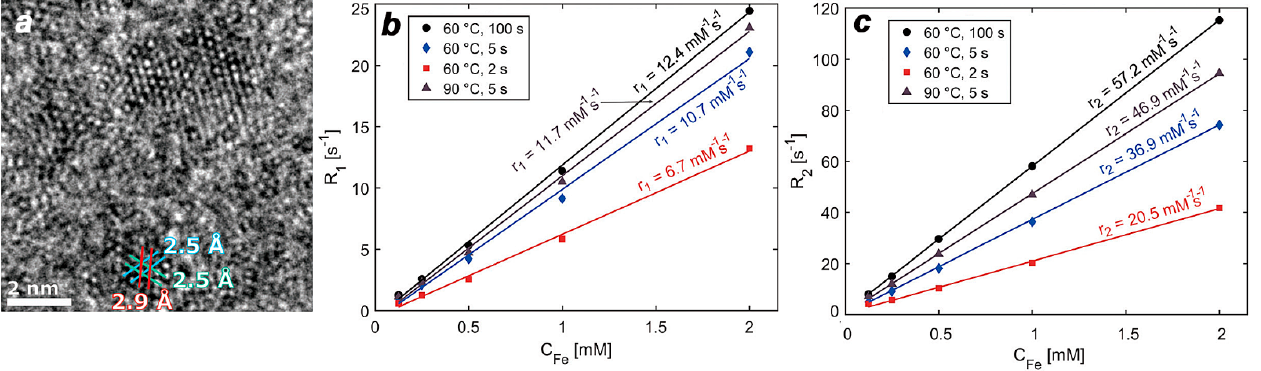
Figure 2. ( a ) HRTEM magnification image of ultra-small IONPs matching the [111] zone axes of magnetite with the two 2.5 Å (113) planes and one 2.9 Å (220) plane (PDF ref. 03-065-3107); ( b ) Relaxation rates R1 (longitudinal) and ( c ) R2 (transversal) vs. iron concentration in the (consecutively diluted) dialyzed samples (CFe) to determine r 1 and r 2 (i.e., the slope) for IONPs synthesized at co-precipitation temperatures and quenching times as indicated. Reprinted/adapted from ref. [139], under a Creative Commons Attribution 3.0 Unported Licence.